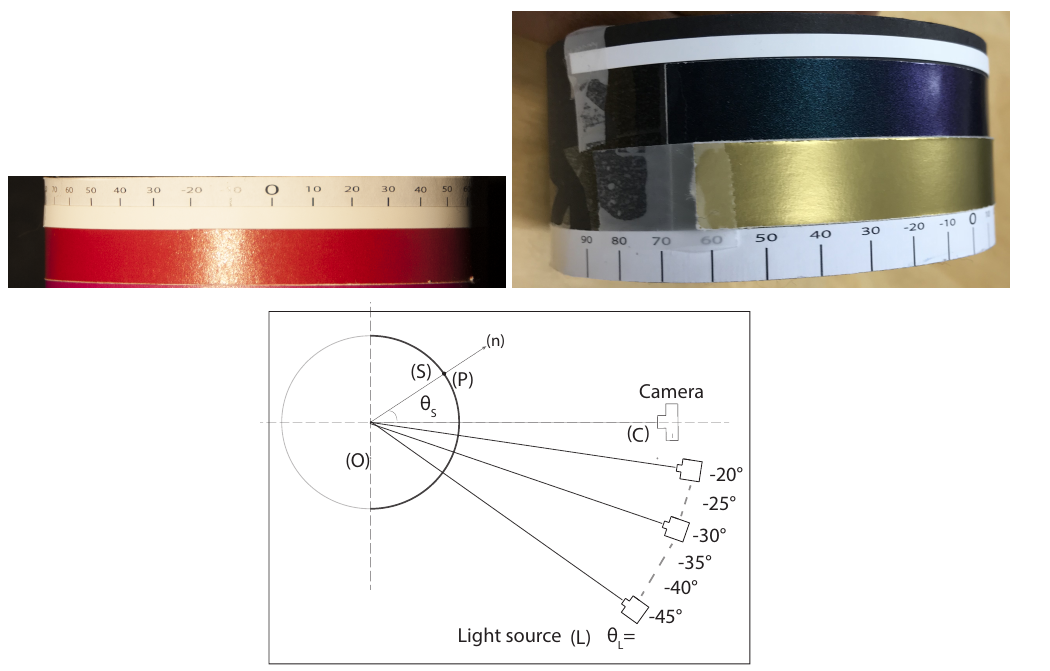
Figure 4. Sample measurement at six different illumination directions ( θ L ) and image captured at θ L = − 20 ◦